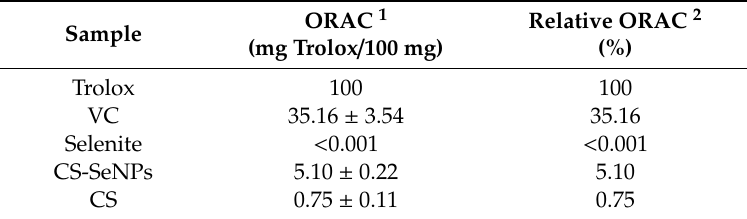
Table 2. Oxygen radical absorbance capacity (ORAC) results ( n = 3).